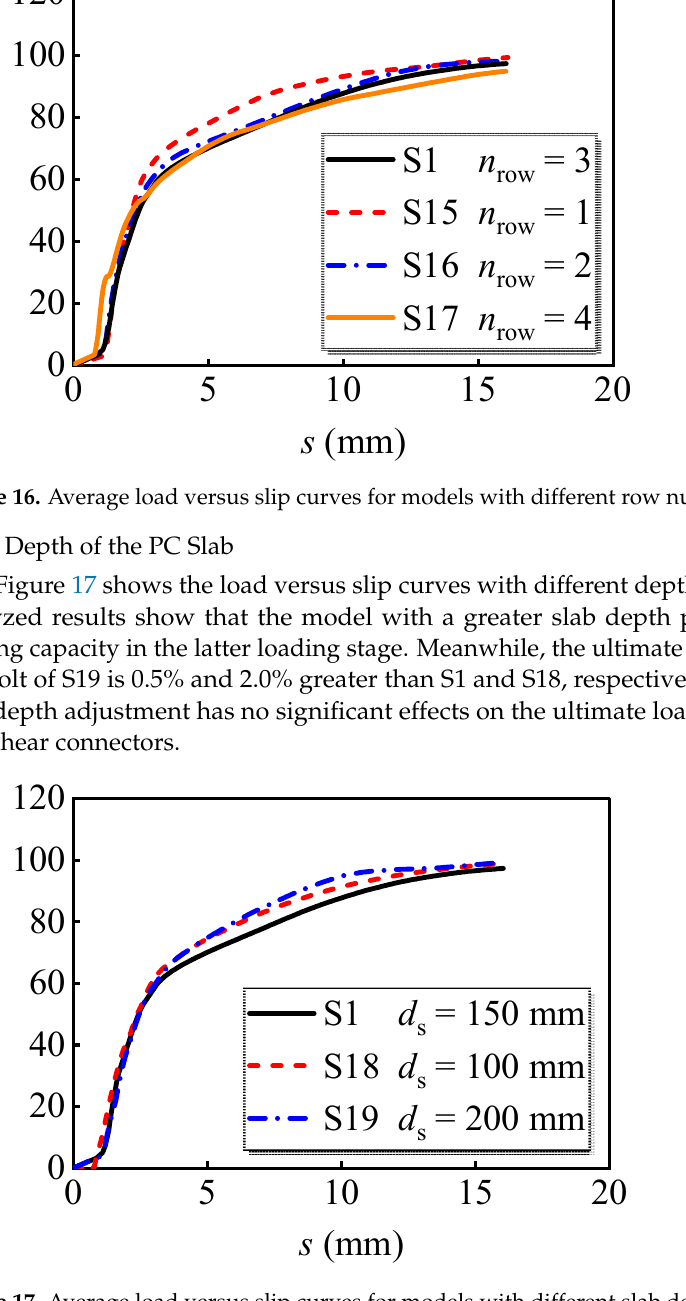
pacity of S15 is 1.2%, 2.1%, and 4.7% greater than S16, S1, and S17, respectively. This phe-